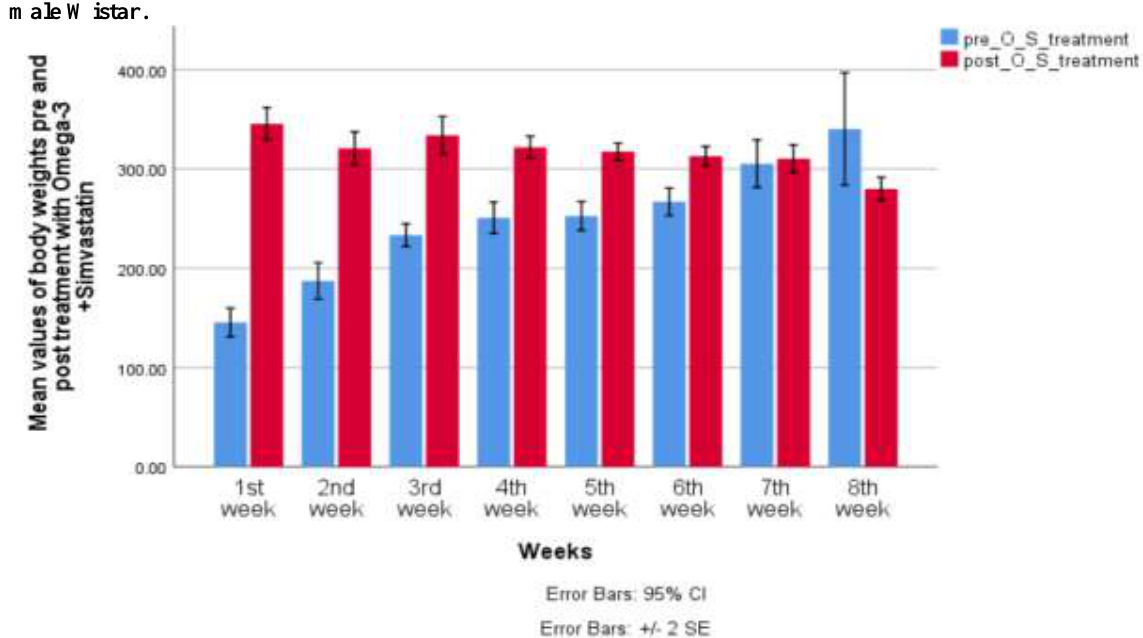
Figure 6. Demonstrate the effect of pre- and post-treatment with omega-3 and simvastatin on body weights in male Wistar